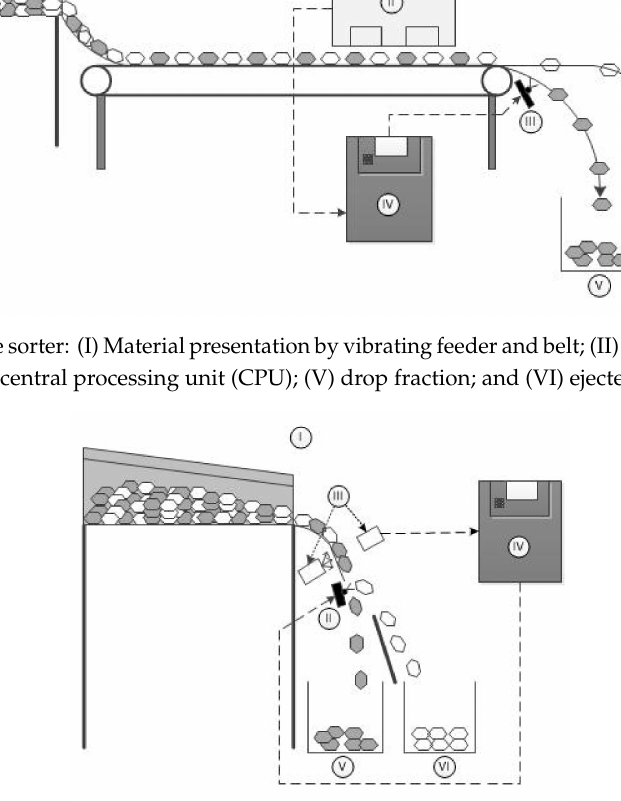
Figure 2. Chute-type sorter: (I) Material presentation by vibrating feeder and sliding chute; (II) sensors; (III) ejection nozzle array; (IV) CPU; (V) drop fraction; and (VI) ejected